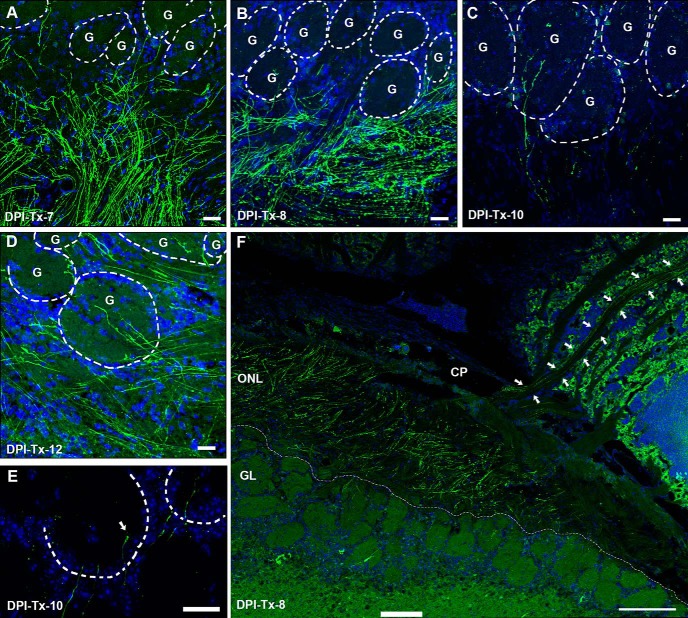
Tracking ZsGreen+ axon extension in Ascl1CreERT2/R26RZsGreen double transgenic mice at different time points following 4OH-Tx injection. A, B, F, ZsGreen+ axons innervate iONL profoundly at 7-DPI-Tx (A), and they surround ventral glomeruli closely at DPI-Tx-8; some scarce axons enter the GL (B, F). Panoramic sagittal view showing a ZsGreen+ axon pathway (arrows) from the OE to the ventrolateral OB (F). C, D, Labeled axons unequivocally innervate glomerular neuropil by 10 d following basal cell division. E, Detail of ZsGreen+ axon growth cones (arrow) in the GL. DRAQ-5 is in blue. Dashed circles delineate glomeruli in A–D, and each glomerulus is designated by the letter “G.” Dotted white lines delineate the limit between the GL and the ONL in F. CP, Cribriform plate; GL, glomerular layer. Scale bars: A–D, 25 μm; E, 20 μm; F, 200 μm.